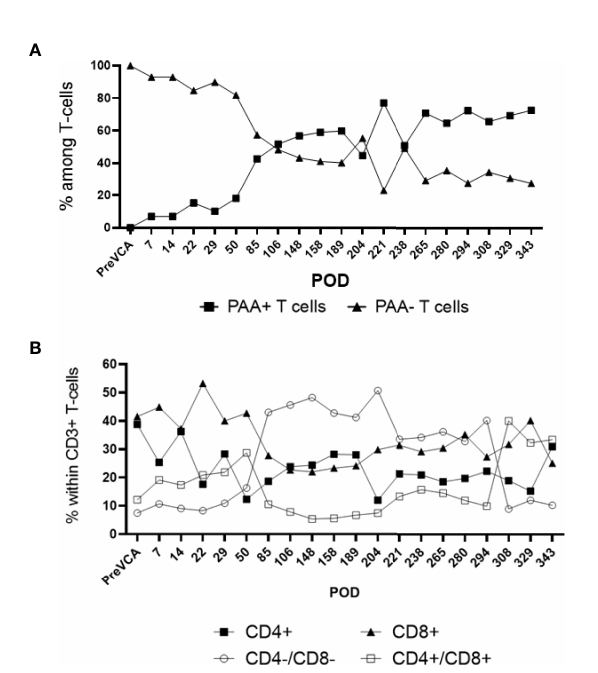
FIGURE 4 | Sub-analysis of T cell subsets in multi-lineage mixed chimerism. Post-transplantation, as bone marrow reconstitution progresses, the percentage of donor (PAA+) and recipient (PAA-) T cells approaches equilibrium at around POD100, remained stable and varied between 50 to 70% of donor T cells to experimental endpoint (A) . The population of double negative (CD4-/CD8-) T cells increase from around POD 50 onwards (following cessation of FK506) and remained at about 20 to 40% of overall CD3+ T cell to experimental endpoint (B) . The results shown were obtained in one tolerant swine and are representative of all tolerant swine tested individually.